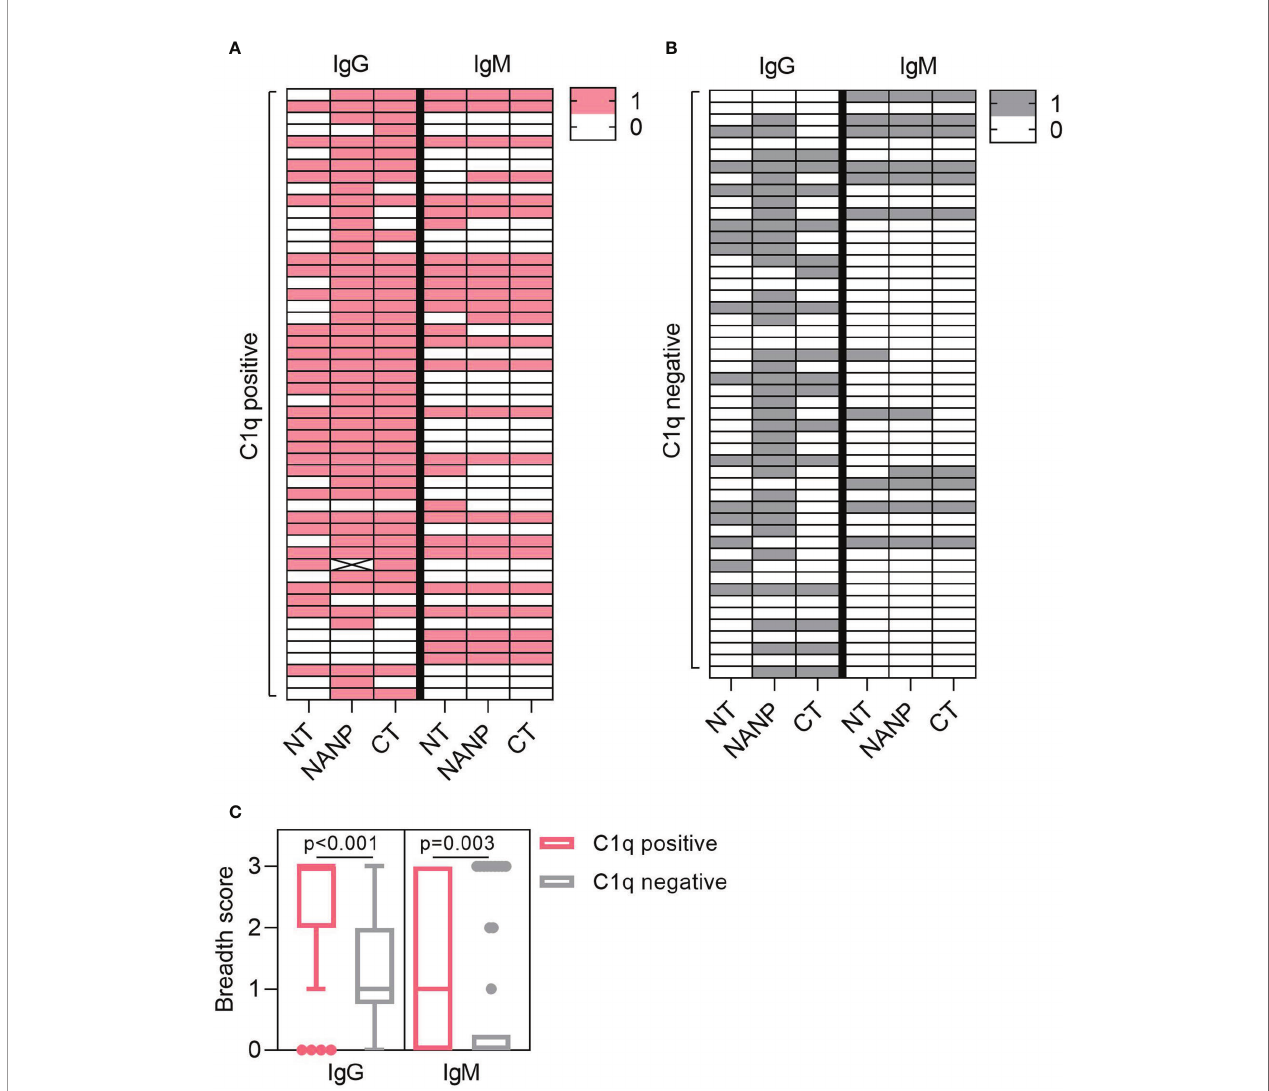
FIGURE 3 | Antibody breadth is associated with C1q- fi xation. Plasma collected from malaria exposed adults (n=102) were tested for C1q- fi xation to CSP and strati fi ed into (A) C1q positive (n=52) and (B) C1q negative (n=50) groups. Heat-maps display IgG/IgM seropositivity to antigens representing the N-terminal (NT), central-repeat (NANP) and C-terminal (CT) regions of CSP. Each row represents an individual participant that was de fi ned as seropositive (score = 1) or seronegative (score = 0) for IgG or IgM to each antigen. (C) The breadth scores for IgG and IgM were calculated by combining the seropositivity score for all three antigens (total breadth scores were between 0 and 3). The IgG and IgM breadth score for the C1q positive and C1q negative groups are shown as box plots (box represents the 25th and 75th percentile, whiskers represent the highest and lowest values within 1.5xIQR and values outside this range are shown as dots) and were compared using the Mann-Whitney U